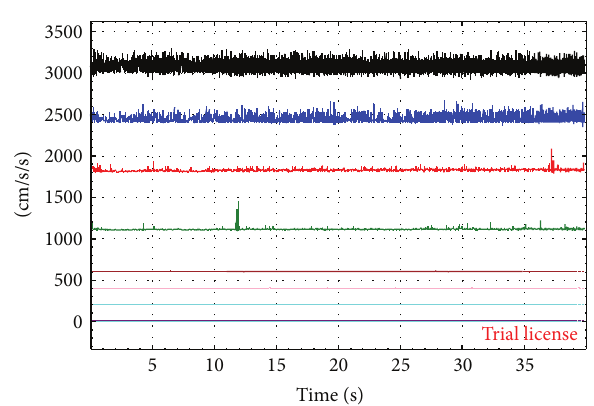
Figure 9: Instant frequency time history of IMF.